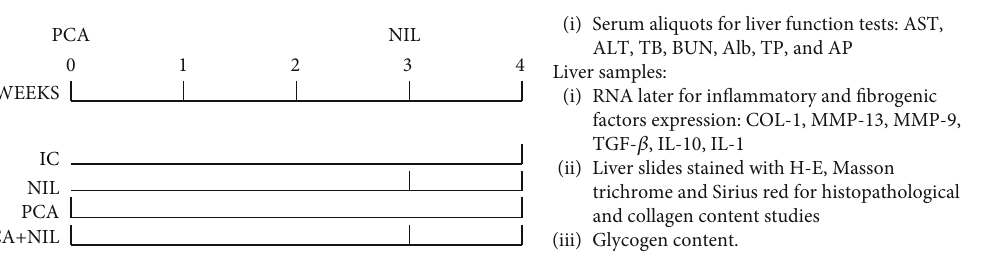
Figure 1: Experimental schedule. Rats were divided into intact control (IC), neurointermediate pituitary lobectomy (NIL), portacaval anastomosis (PCA), and the PCA+NIL groups. PCA and NIL surgeries were performed at weeks 0 and 3, respectively. At week 4, all animals were anesthetized, bled, and euthanized. Serum aliquots were used for assessing functional liver test, tissue liver samples were used to assess in fl ammatory and fi brogenic factors expression, histopathological studies and collagen and glycogen contents. n = 4 − 6